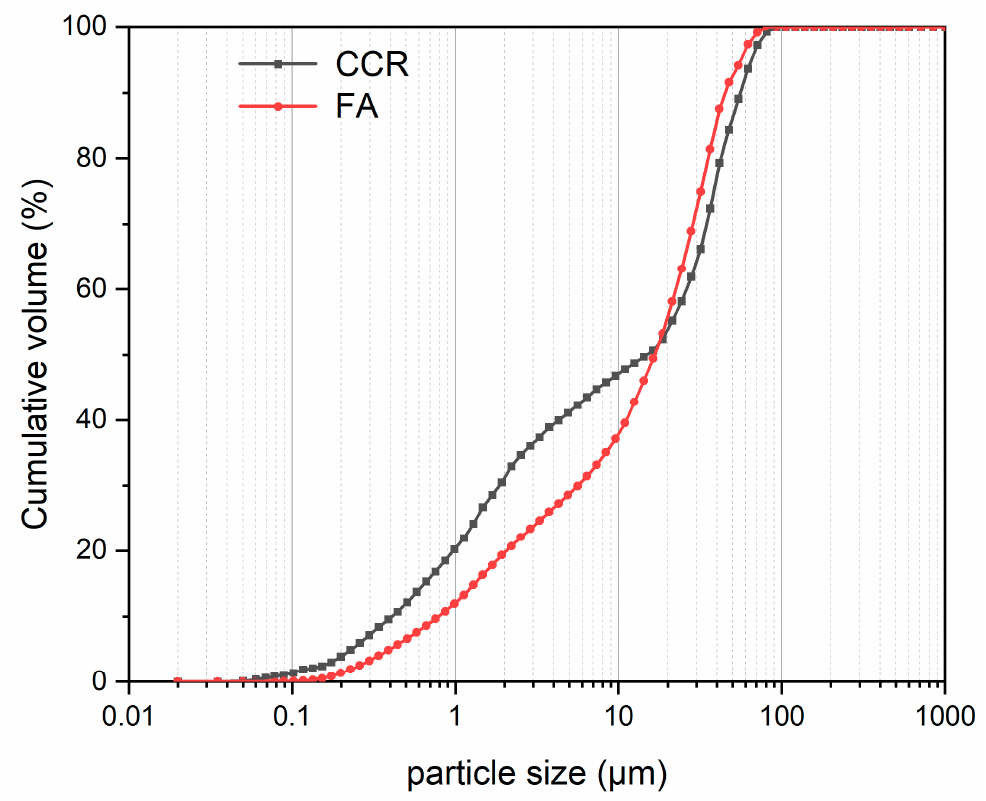
Figure 1. Particle size distributions of FA (fly ash) and CCR (calcium carbide